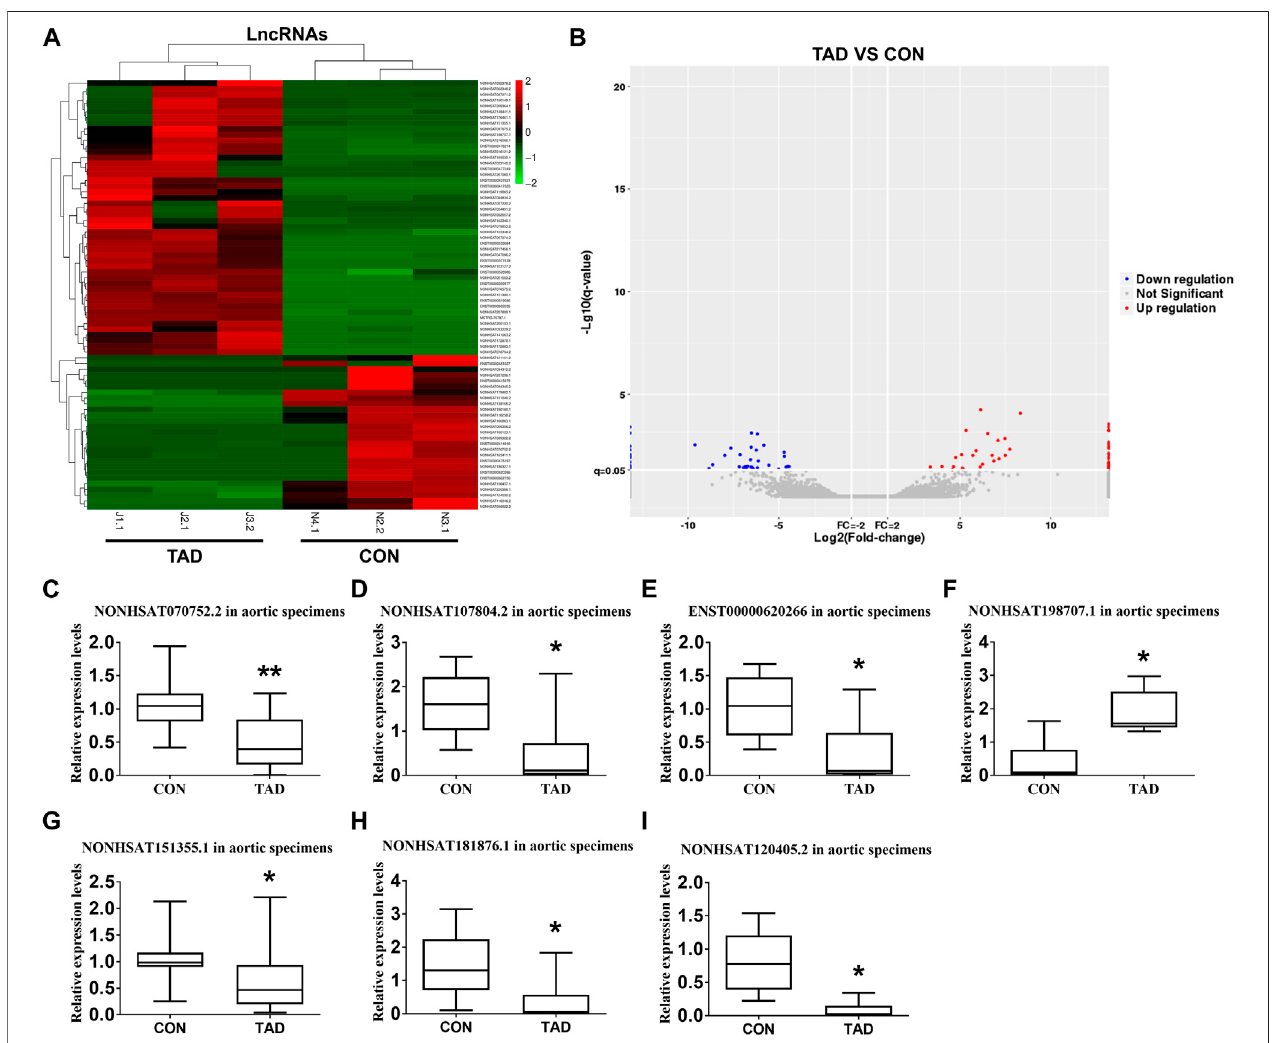
FIGURE 1 | Differentially expressed lncRNAs between TAD patients and healthy controls. (A) The hierarchically clustered heatmap illustrating differentially expressed lncRNAs between TAD patients and healthy controls. Up-regulated lncRNAs are denoted in red and down-regulated in green ( n (cid:1) 3 per/group). (B) The volcanoplotillustratesthedifferentiallyexpressedlncRNAsbetweentheTADpatientsandhealthycontrols,withreddotsrepresentingup-regulatedgenesandbluedots representing down-regulated genes (log2fold change ≥ 2; q ≤ 0.05) ( n (cid:1) 3 per/group). (C – I) qRT-PCR was used to compare the relative expression levels of seven aberrantly expressed lncRNAs (NONHSAT107804.2, ENST00000620266, NONHSAT120405.2, NONHSAT181876.1, NONHSAT070752.2, NONHSAT151355.1, and NONHSAT198707.1) ( n (cid:1) 15 in thecontrol group, n (cid:1) 24 in theTAD group). The β -actin was selected as ahousekeeping gene. Con represents normal aortictissue from healthy donors; TAD represents aortic dissection tissue from TAD patients. Data (C – I) were expressed as mean ± SEM and compared by Student ’ s t-test. * p <